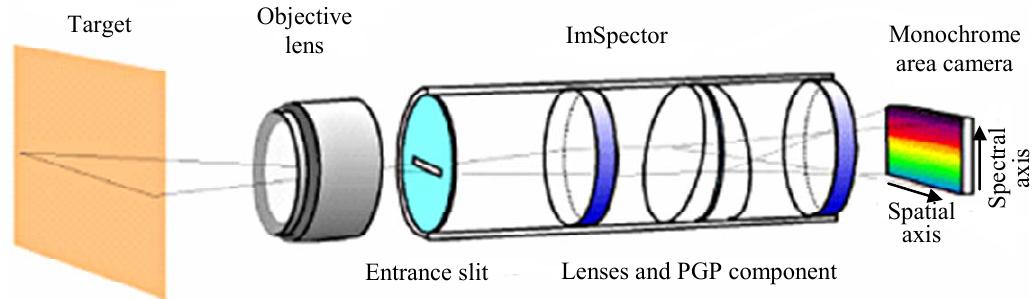
Figure 2. Sketch of a spectrometer